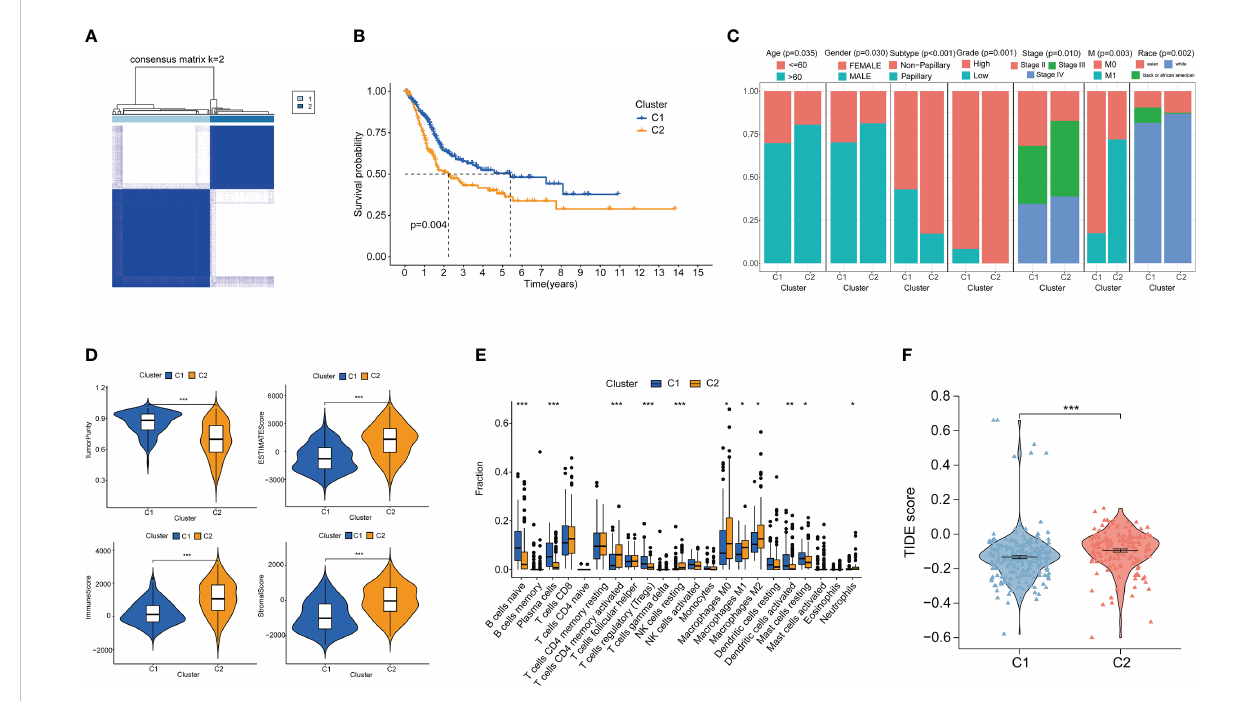
FIGURE 2 Cluster analysis and the association between different clusters with tumor microenvironments and immunotherapy. (A) Consensus clustering heat map when k=2. (B) Survival curves of two clusters. (C) Age, Gender, Subtype, Grade, Stage, M stage and Race between the two clusters. (D) Differences in tumor purity, ESITIMATE score, stroma and immune cells between the two clusters. (E) CIBERSORT score of immune cell in fi ltration between the two clusters. (F) TIDE score was used to compare the immunotherapy effect between Cluster 1 and Cluster 2. * p < 0.05 、 ** p < 0.01, *** p <